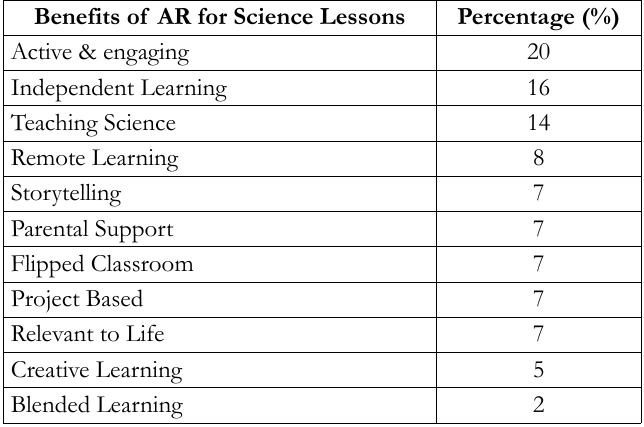
Table 14. Percentage of teacher references to AR Benefits for Science (Contextual Interviews)